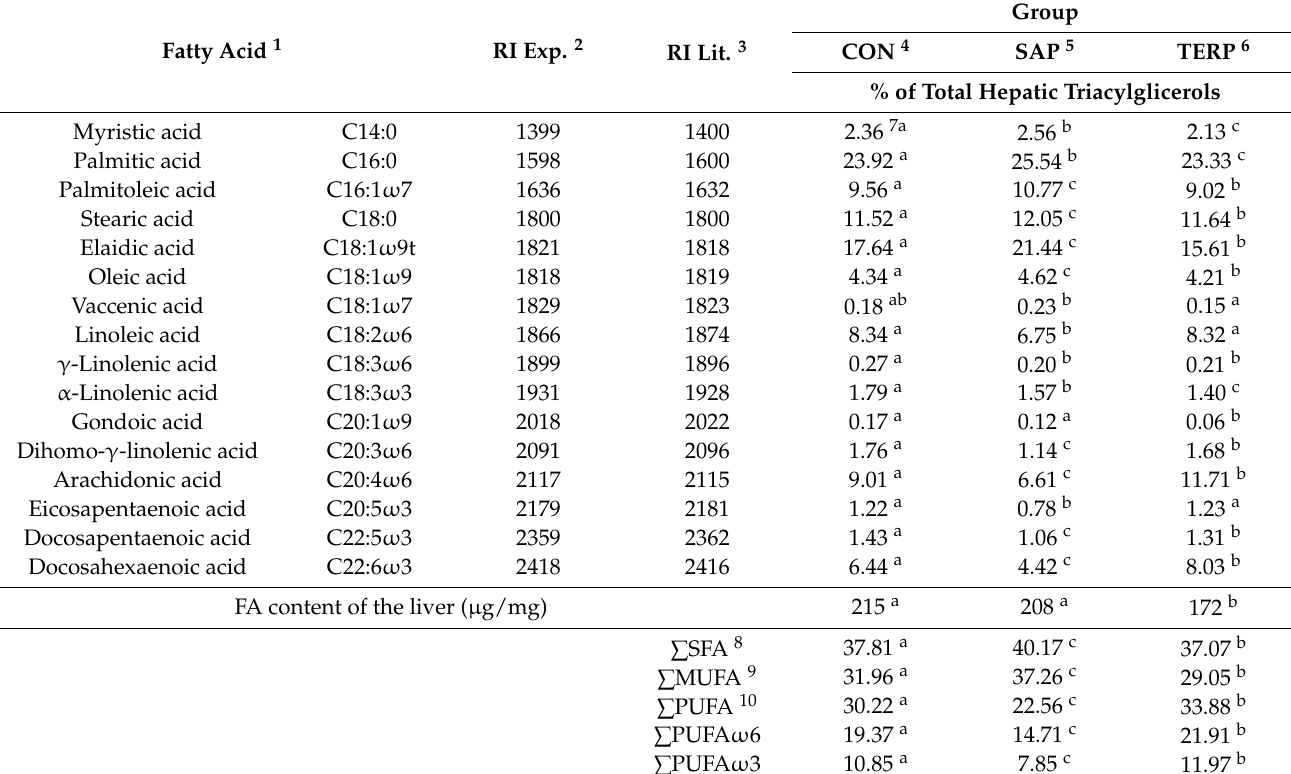
Table 8. Fatty acid profile in Zucker rat